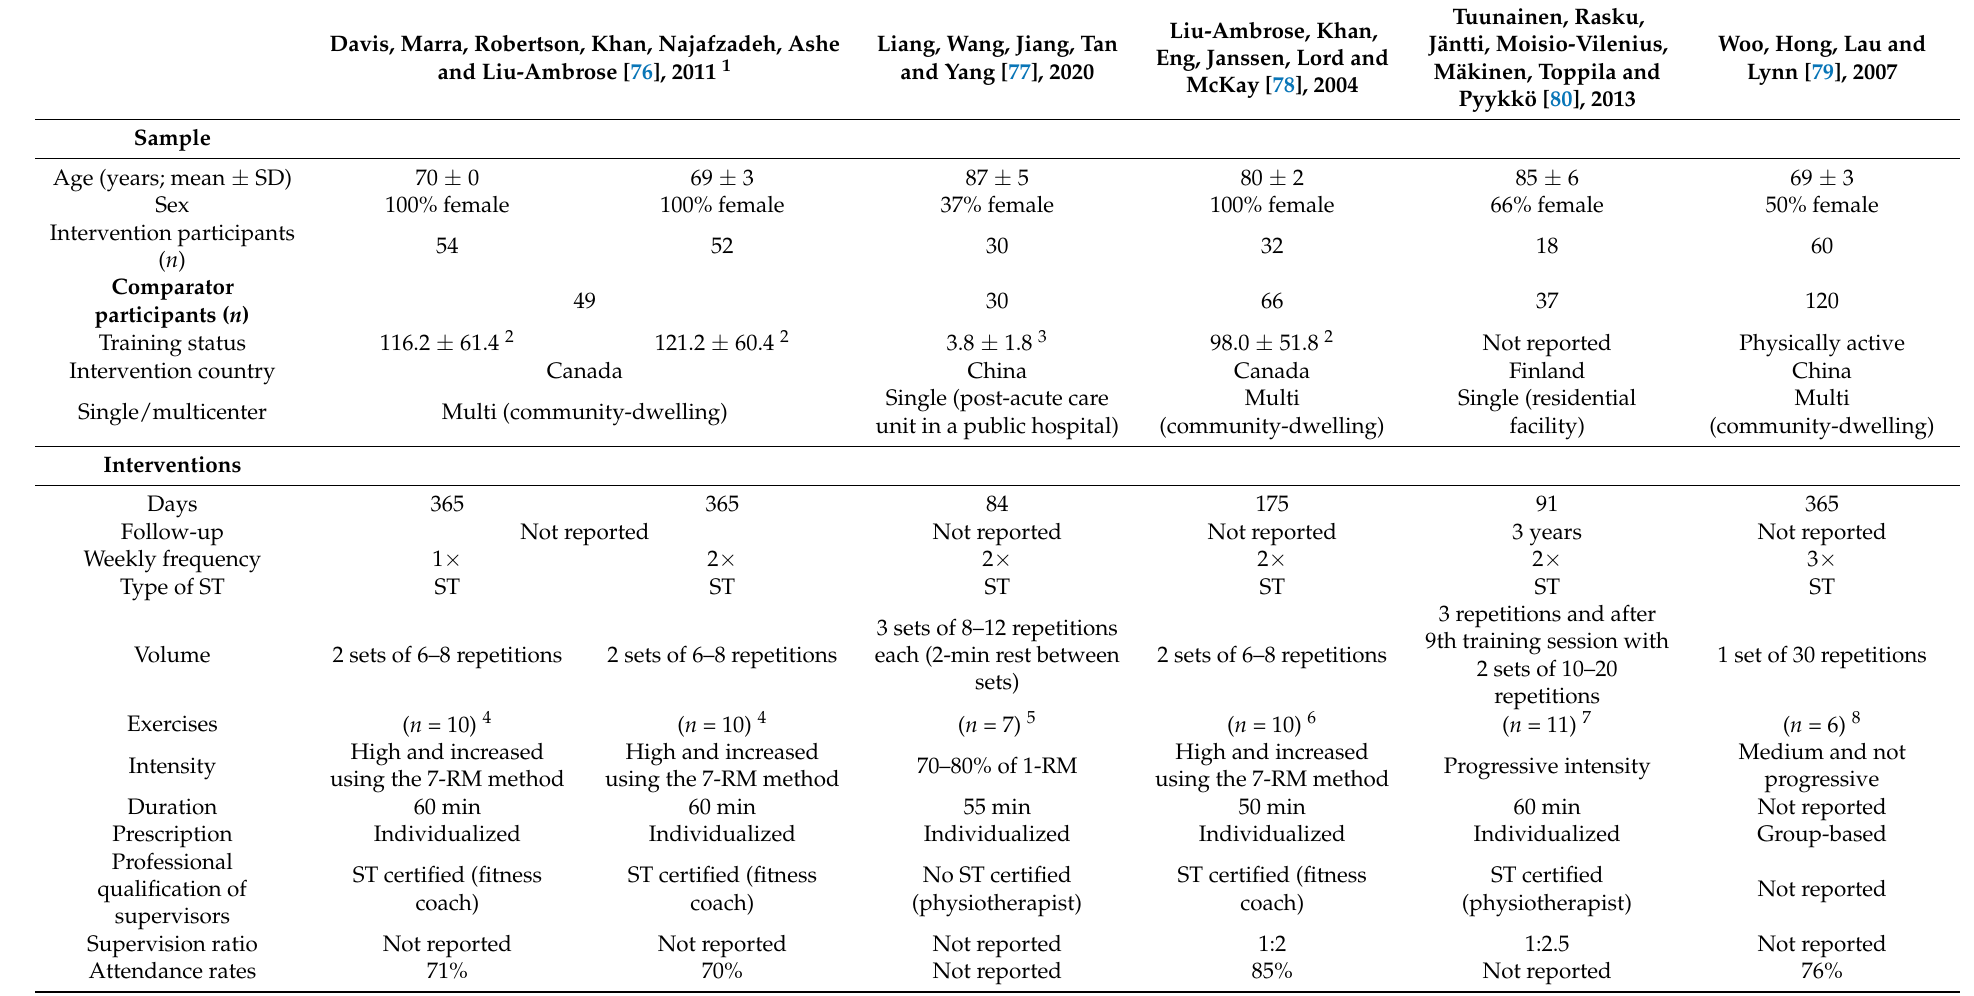
Table 1. Characteristics of the